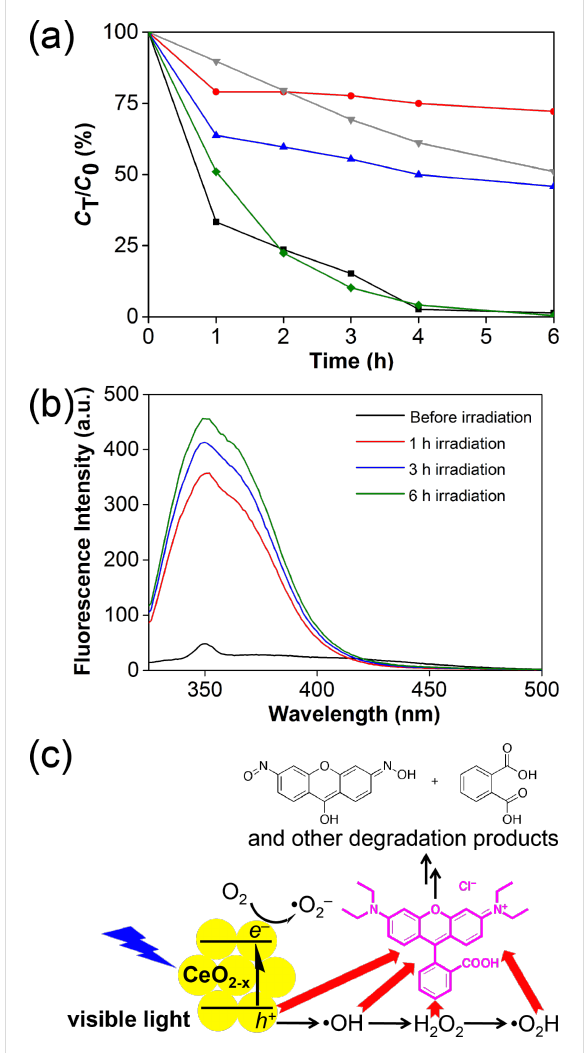
Figure 5: (a) Photocatalytic degradation of RhB over time at 554 nm, in the absence of scavengers (black), and the presence of h + (red), • OH (blue), e – (green), and • OOH/ • O 2 − scavengers (grey). (b) Growth of the fluorescence intensity of 2-hydroxyterephthlate as a probe for hydroxyl radicals. (c) Proposed pathway for photocatalytic RhB de-